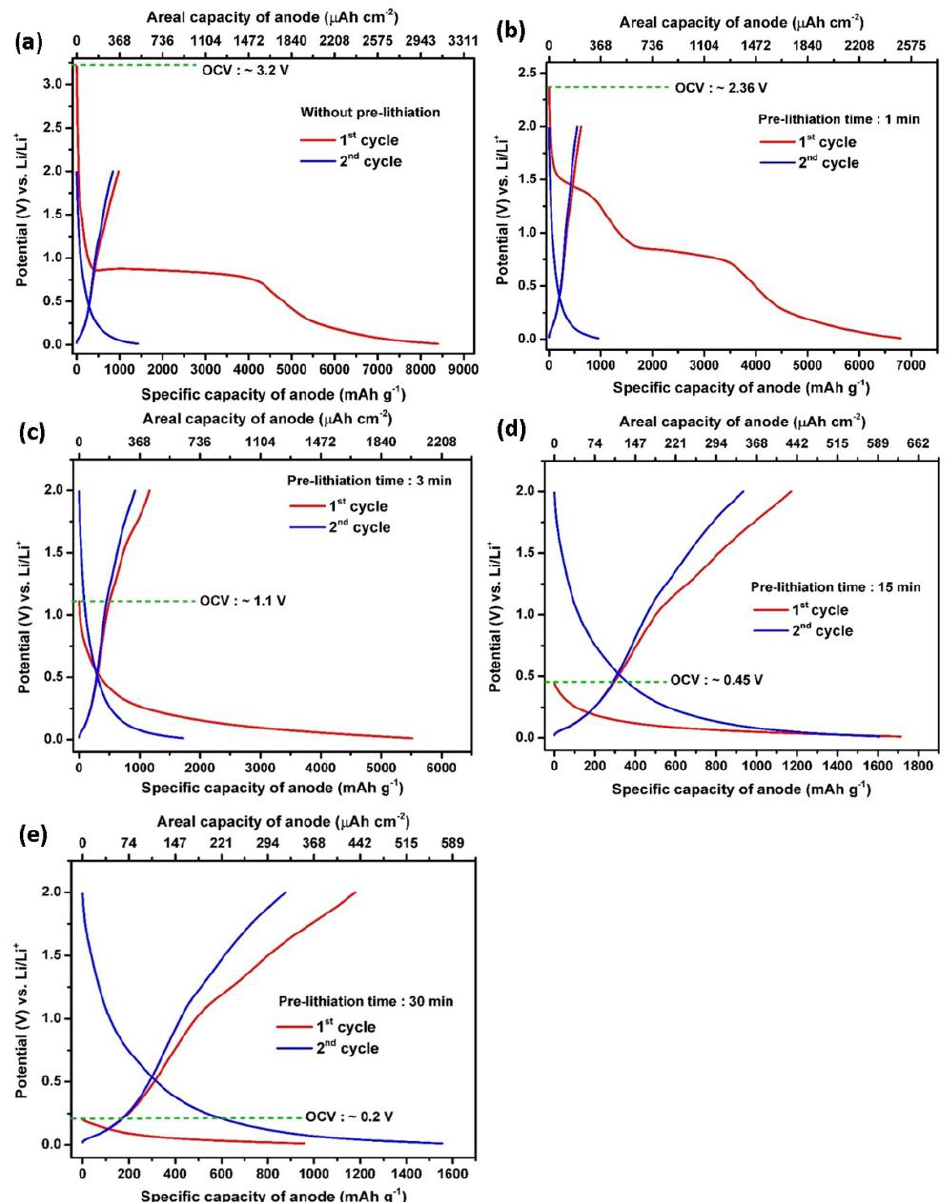
Figure 4. Initial charge–discharge potential profiles of the pristine CNT ( a ), pre-lithiated CNT for 1 min ( b ), pre-lithiated CNT for 3 min ( c ), pre-lithiated CNT for 15 min ( d ) and pre-lithiated CNT for 30 min ( e ) recorded at 2 C rate.